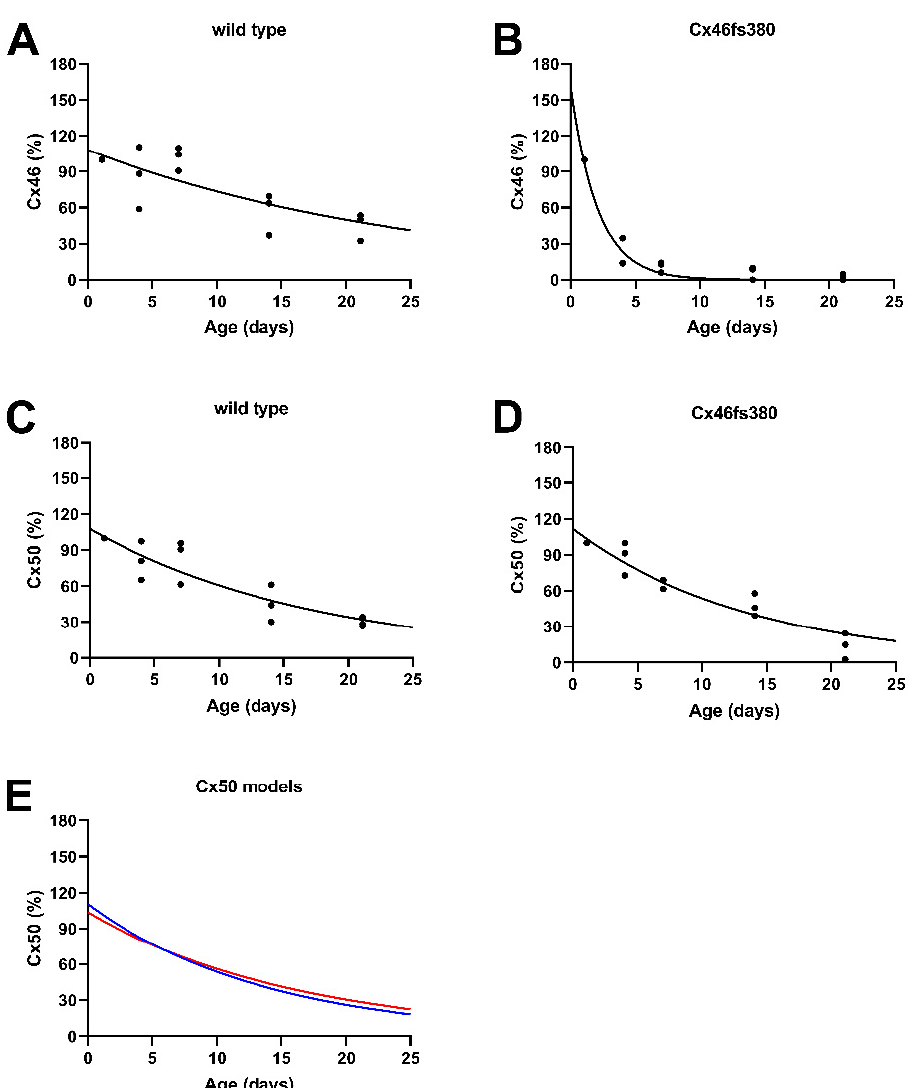
Figure 2. The age-dependent decreases in total levels of Cx46 and Cx50 in the lenses of wild-type and homozygous Cx46fs380 mice could be fit to single exponential curves. ( A – D ) The data from the three independent sets of immunoblots of connexin levels shown in Figure 1C,D were fit to single exponential decay curves of the form y = C*e − k*t . ( A , B ) The data for Cx46 levels were best fit by y = 108.216*e − 0.0387*t (r 2 = 0.854) in wild-type lenses ( A ), and by y = 161.174*e − 0.4807*t (r 2 = 0.997) in Cx46fs380 lenses ( B ). ( C , D ) The data for Cx50 levels in wild-type lenses ( C ) were best fit by y = 107.677*e − 0.0574*t (r 2 = 0.9653), and in homozygous Cx46fs380 lenses ( D ), they were best fit by y = 111.807*e − 0.073*t (r 2 = 0.9538). ( E ) The impact of co-oligomerization of wild-type Cx50 with Cx46fs380 upon Cx50 decay in the homozygous Cx46fs380 lenses was modeled by adding different proportions of the curves from panels C and B. The best fit curve was generated using values corresponding to 90% wild-type Cx50 and 10% mutant Cx46, yielding the curve indicated by the red line (y = 110.45*e − 0.07*t ). It is a rather close match to the curve fit to the actual Cx50 data shown in panel D (blue line).